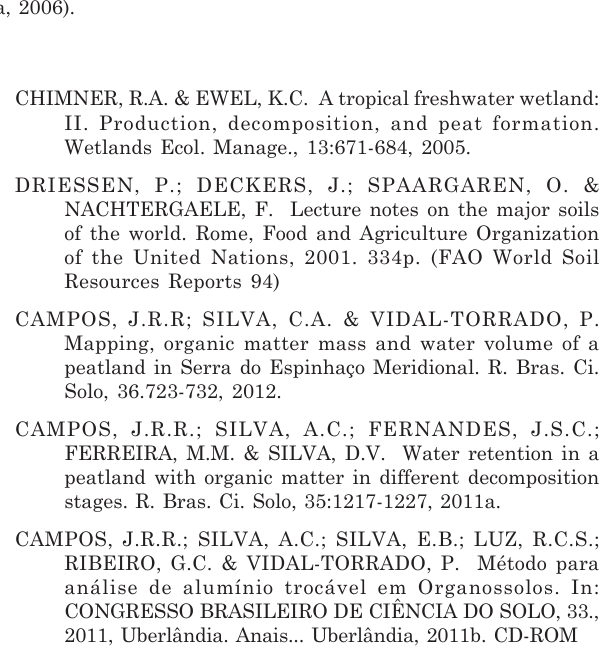
Horizonte tiomórfico, predomínio de material orgânico hêmico, caráter sódico e horizonte glei. Caráter tiomórfico, predomínio de material orgânico hêmico e horizonte glei. Predomínio de material orgânico hêmico. Predomínio de material orgânico fíbrico. Predomínio de material orgânico sáprico e horizonte glei. Predomínio de material orgânico hêmico.